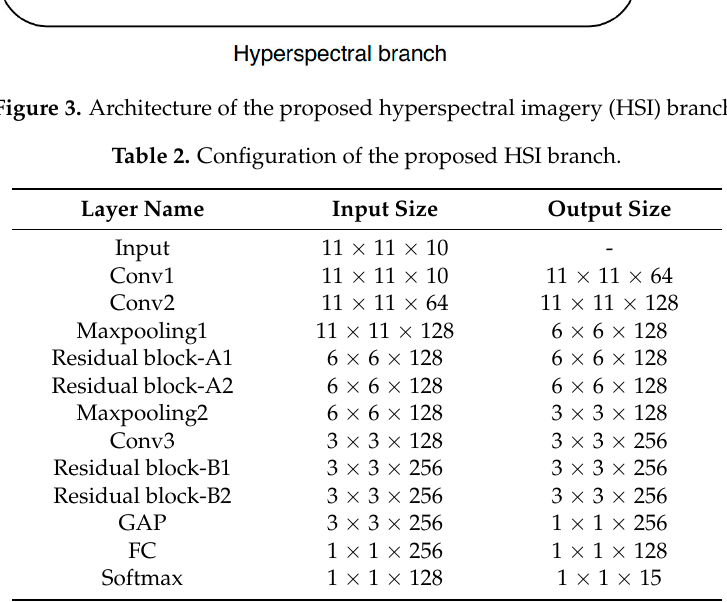
Figure 3. Architecture of the proposed hyperspectral imagery (HSI) branch.